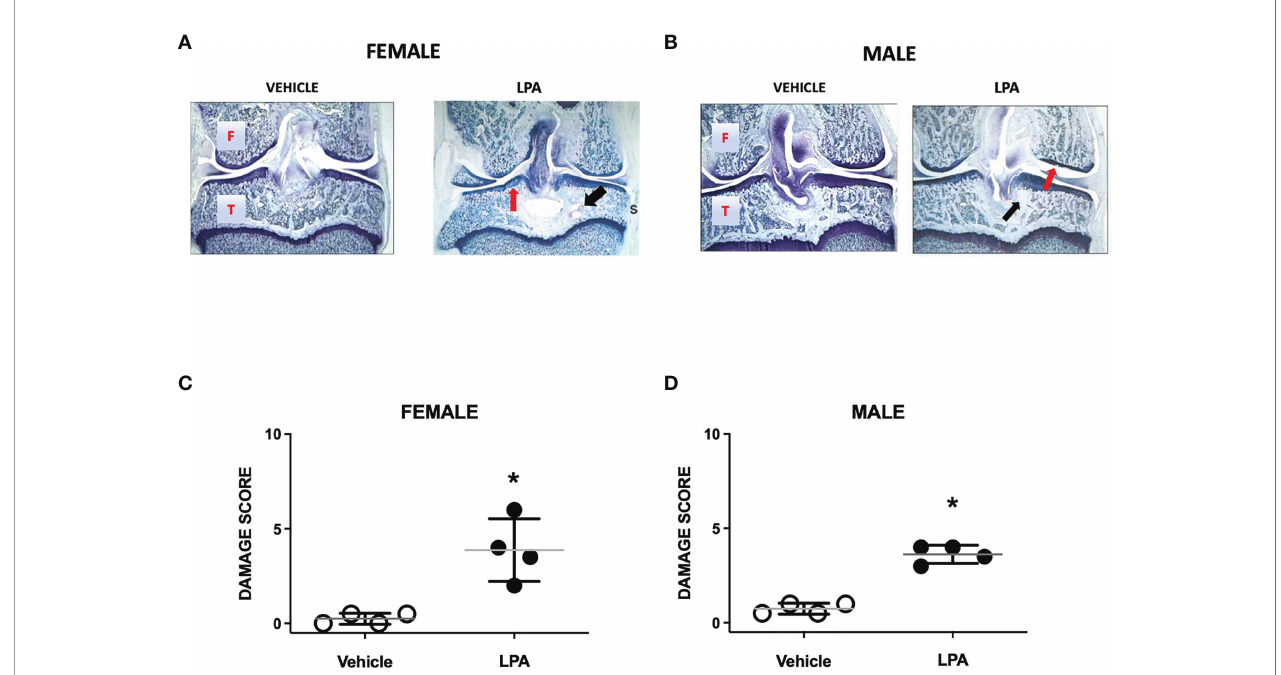
FIGURE 2 | Joint histopathology in male and female LPA-treated knees. Representative photomicrographs of female (A) and male (B) knee joints 28 days following treatment with LPA. Compared to vehicle control, LPA caused proteoglycan loss (red arrows) and focal lesions to subchondral bone (black arrows). (Magni fi cation: X16. T, Tibia; F, Femur; S, Synovium). Damage scores in female (C) and male (D) knees were signi fi cantly higher in LPA-treated joints compared to control. (*P < 0.05, unpaired Student t-test; n =4 animals/group). Data are means ±